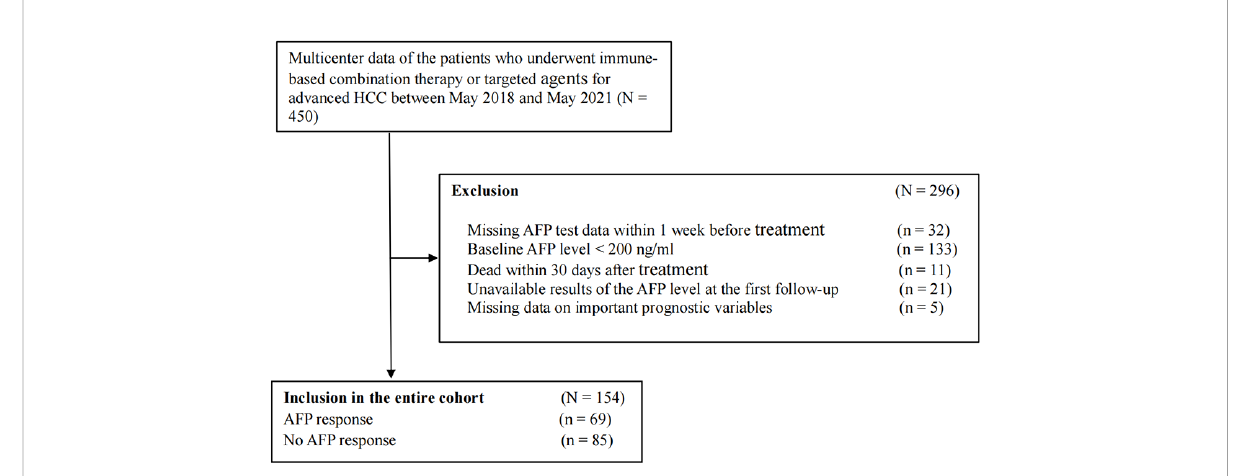
FIGURE 1 Flow chart of the